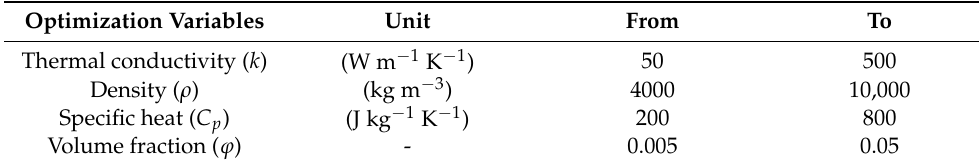
Table 2. Optimization variables and their range of alterations. Optimization Variables Unit From To Thermal conductivity ( k